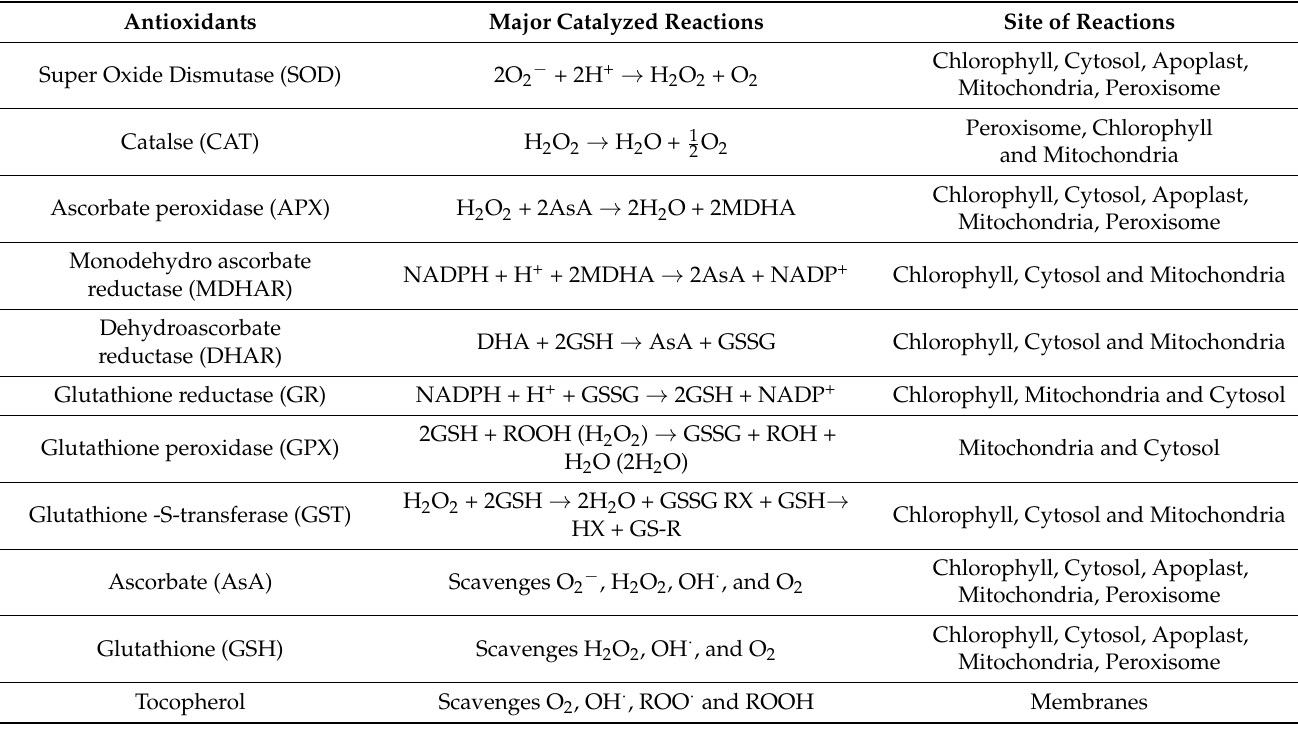
Table 3. ROS scavenging reactions by different antioxidants at different cellular sites (Compiled from Blokhina et al., 2003; Ashraf, 2009; Gill and Tuteja, 2010)